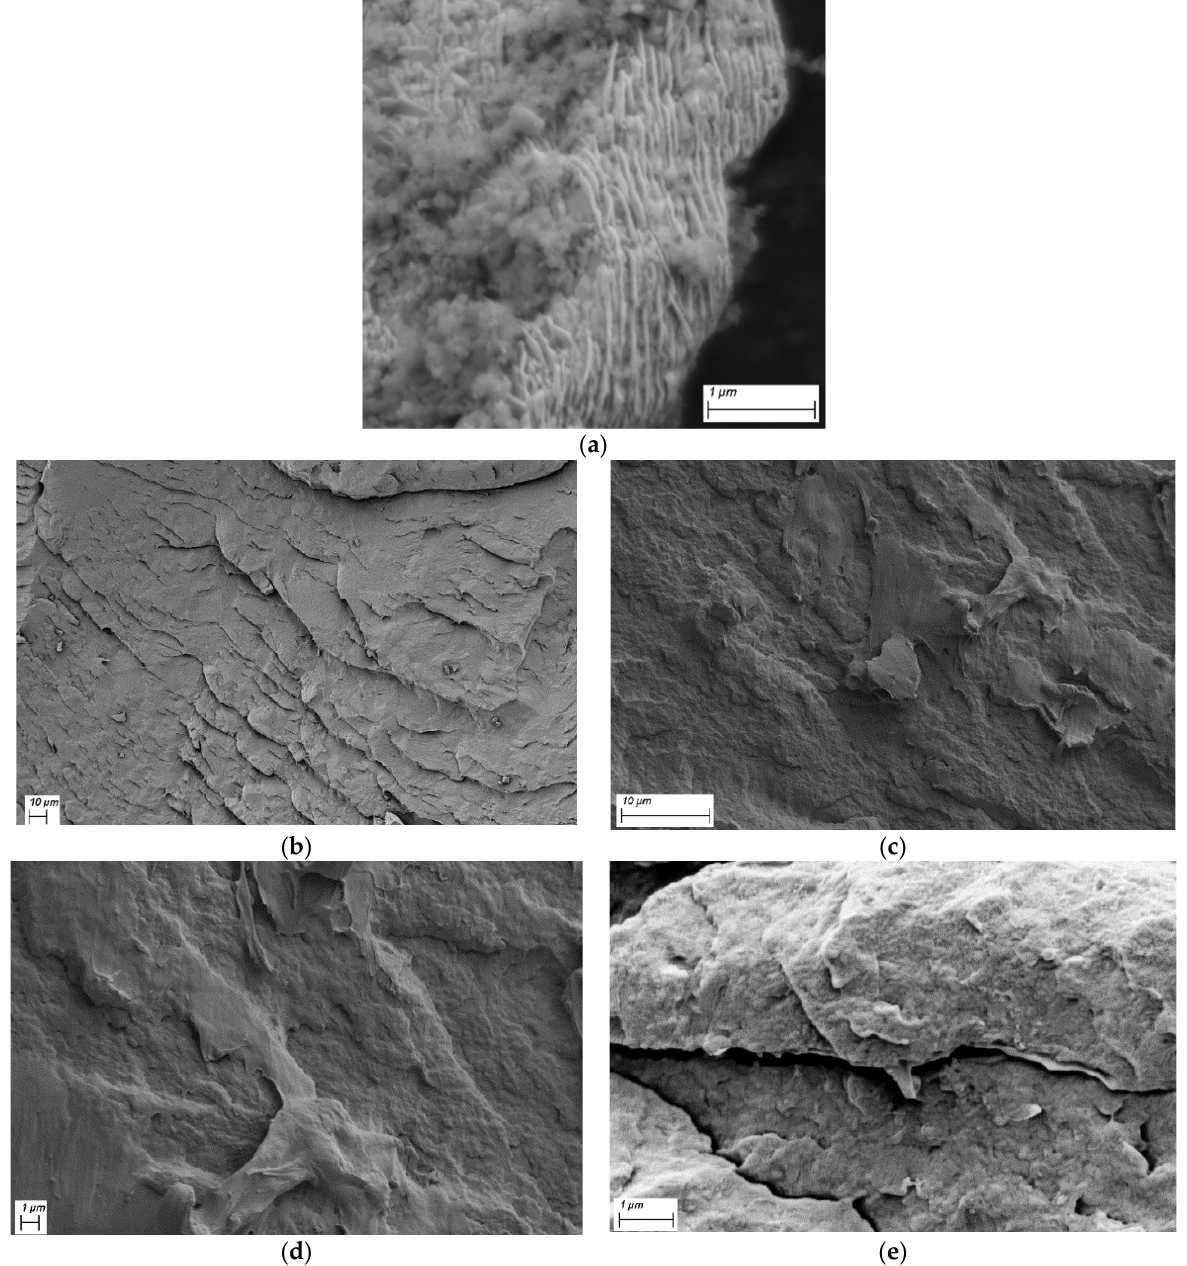
Figure 17. Platelet structure of ( a ) GNP, and Freeze-fractured surfaces of ( b ) neat PA66, ( c ) and ( d ) 0.4 wt% GNP loaded PA66 nanocomposite at different magnifications, and ( e ) 0.2 wt% GNP/PA66 nanocomposite.